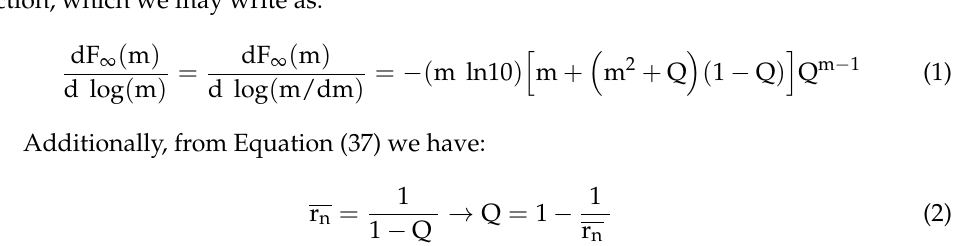
Figure 7. For the aforementioned GPC curve, the deconvolution results are given in Table 2.